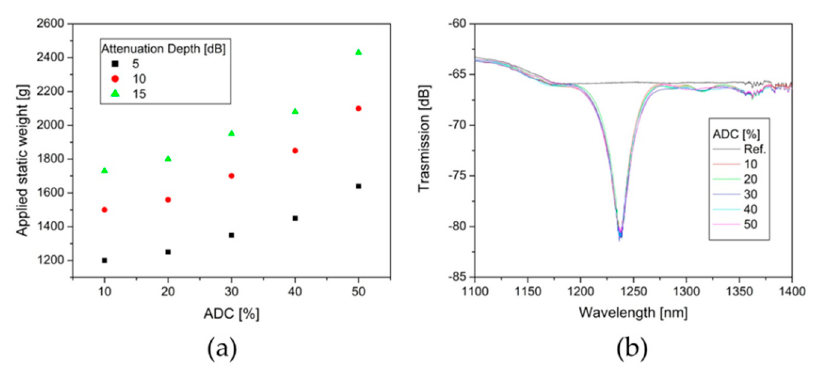
Figure 6. ( a ) Static weights grow for attenuation depth of 5, 10, and 15 dB in the leading rejection band as a function of average duty cycle (ADC). ( b ) Transmission spectrum evolution of the leading rejection band with 15 dB for different values of ADC.